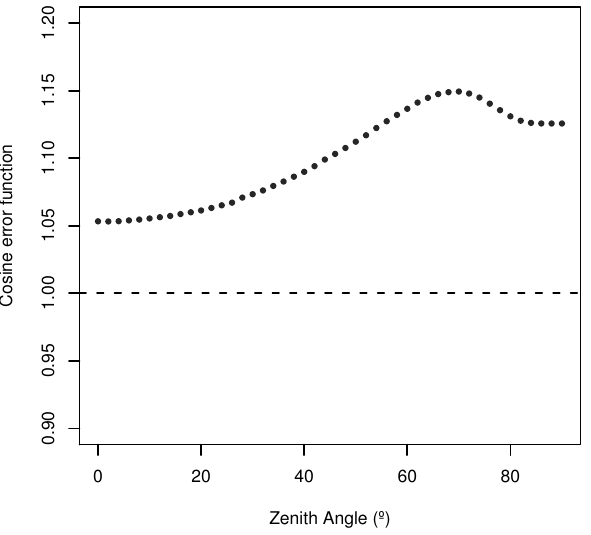
Fig. 4. Variation of the cosine correction function of the YES UVB- 1 radiometer with respect to the solar zenith angle.